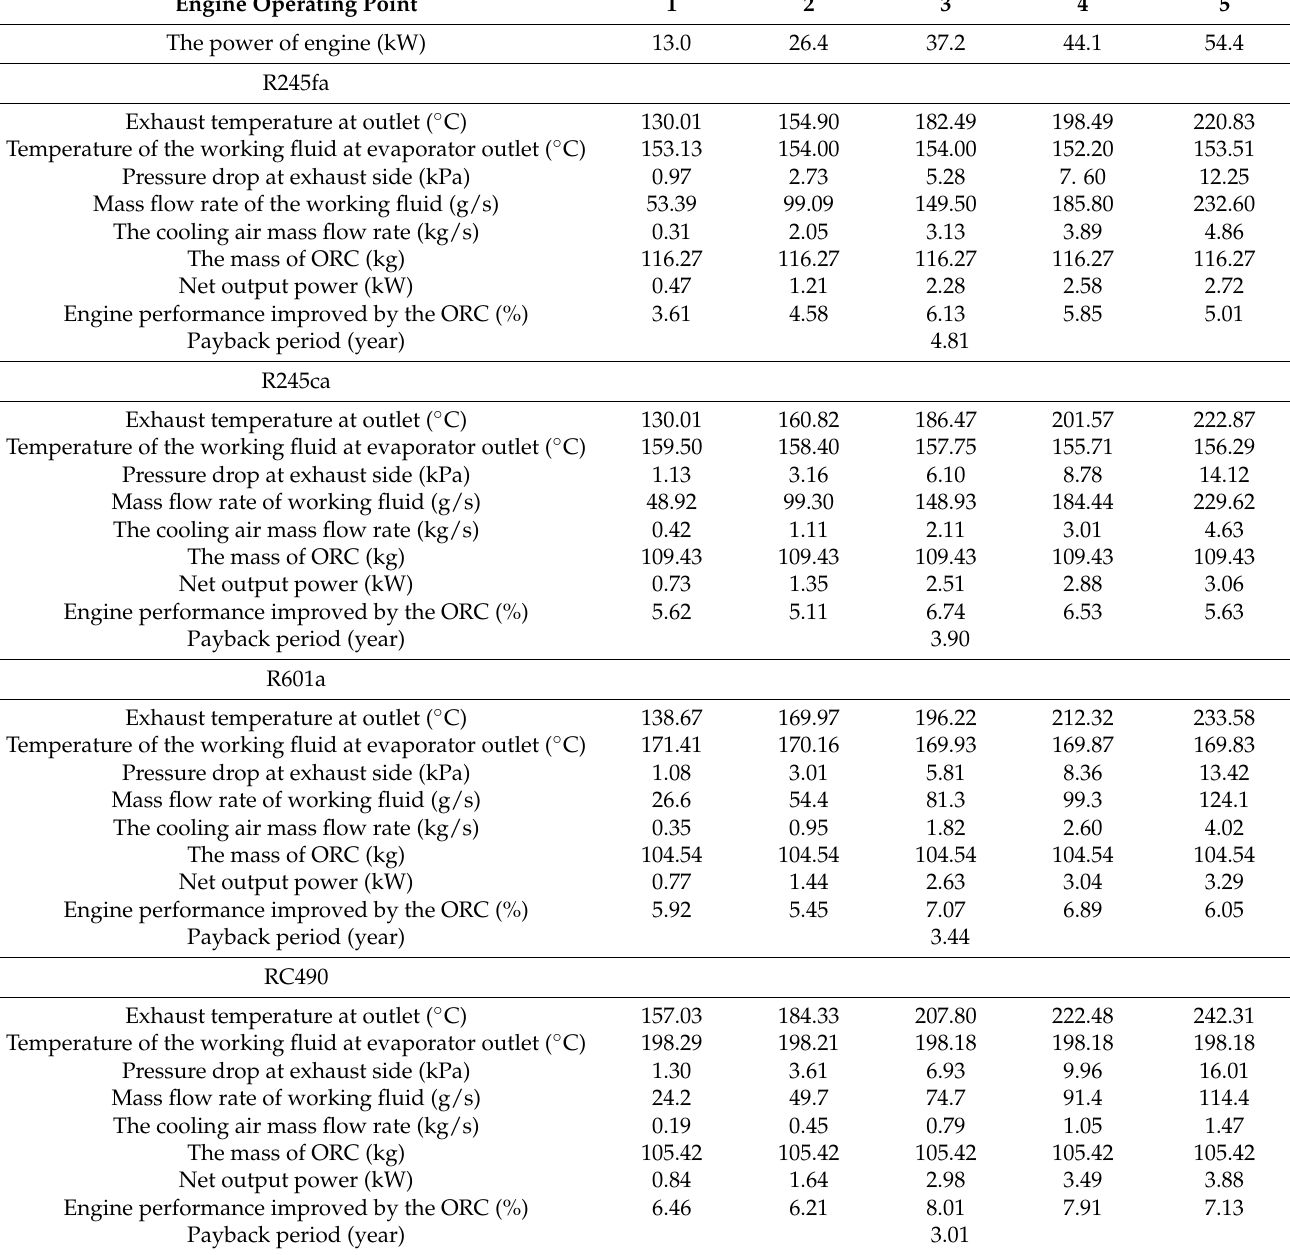
Table 12. The parameters of the ORC system after